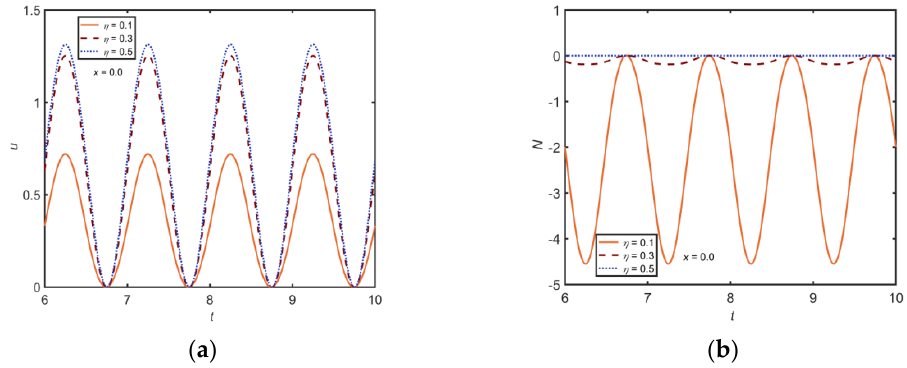
Figure 2. At (cid:1876) = 0 ( a ) the (cid:1873) profile and ( b ) the (cid:1840) profile is presented against (cid:2015) . Figure 2. At x = 0 ( a ) the u profile and ( b ) the N profile is presented against η